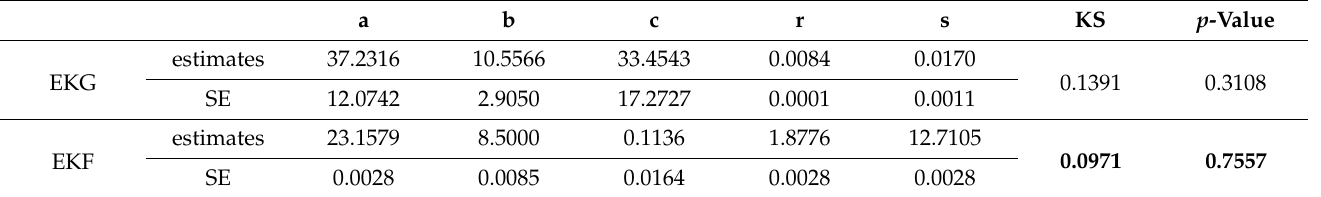
Table 8. MLE with standard error (SE) and KS test for different sets and different model for Wire data.